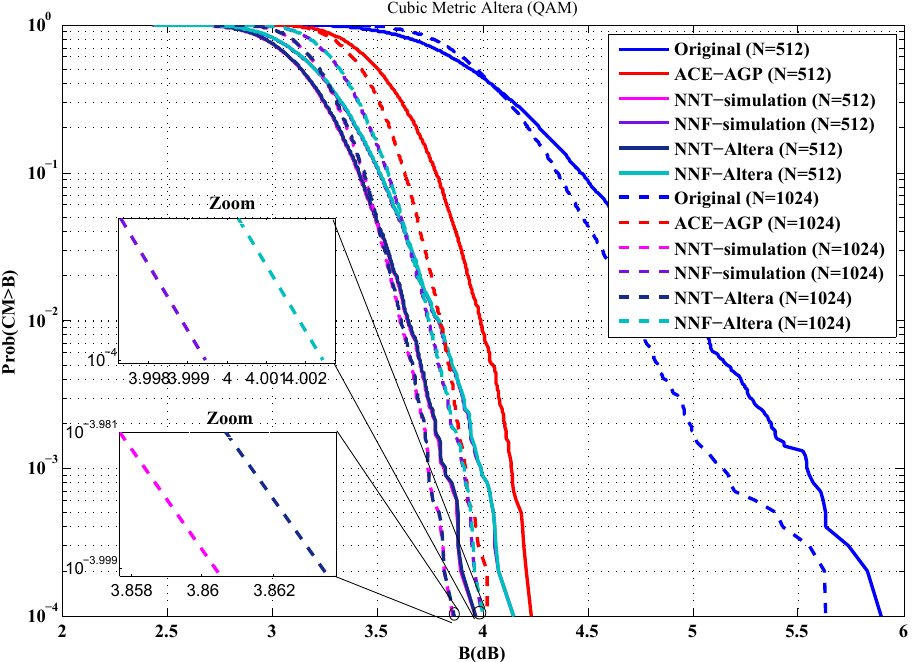
Figure 15. Cubic metric reduction in the case of 16-QAM modulation (Altera